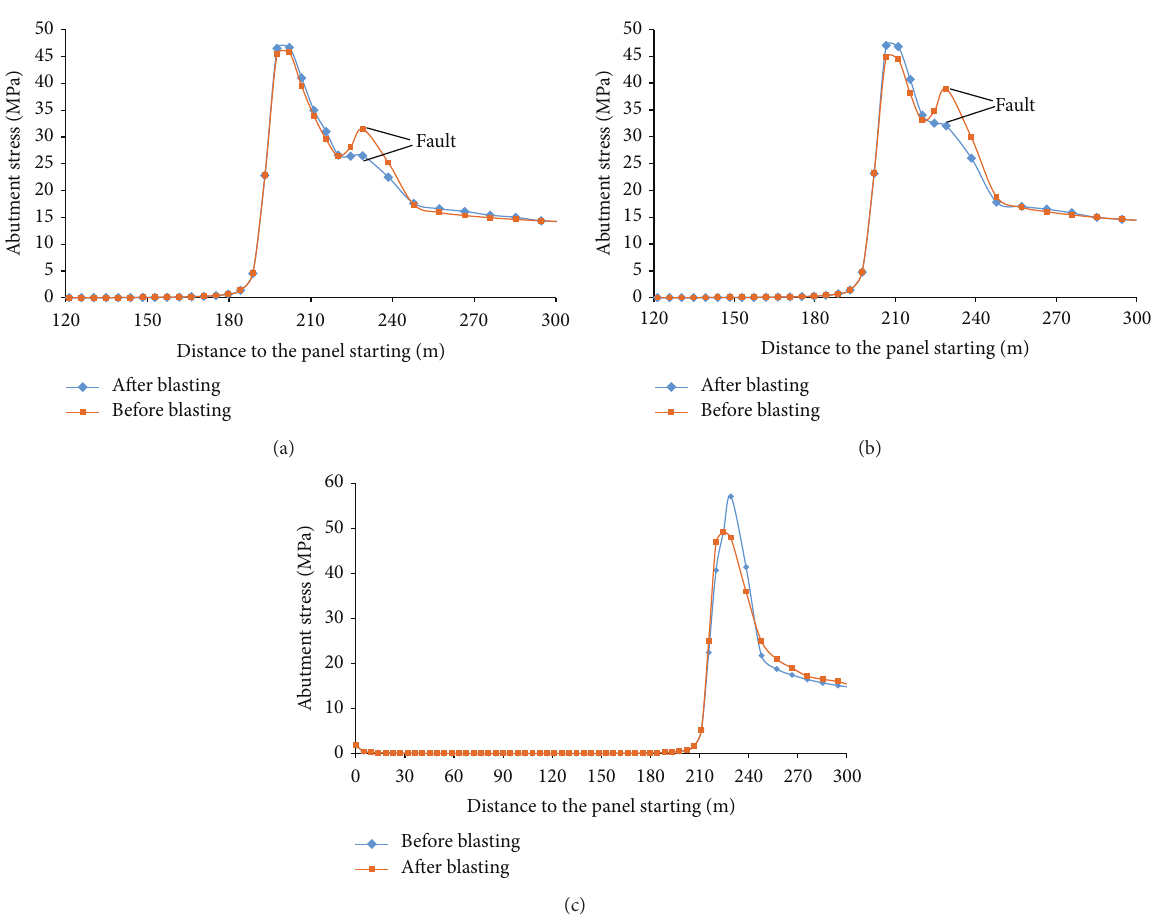
Figure 10: Vertical Stress distribution with different distances between mining panel and the fault before and after blasting ( 𝑝 𝑑𝑚 = 30 MPa, depth = 500m): (a) the distance is 30 m; (b) the distance is 20 m; and (c) the distance is 10m.